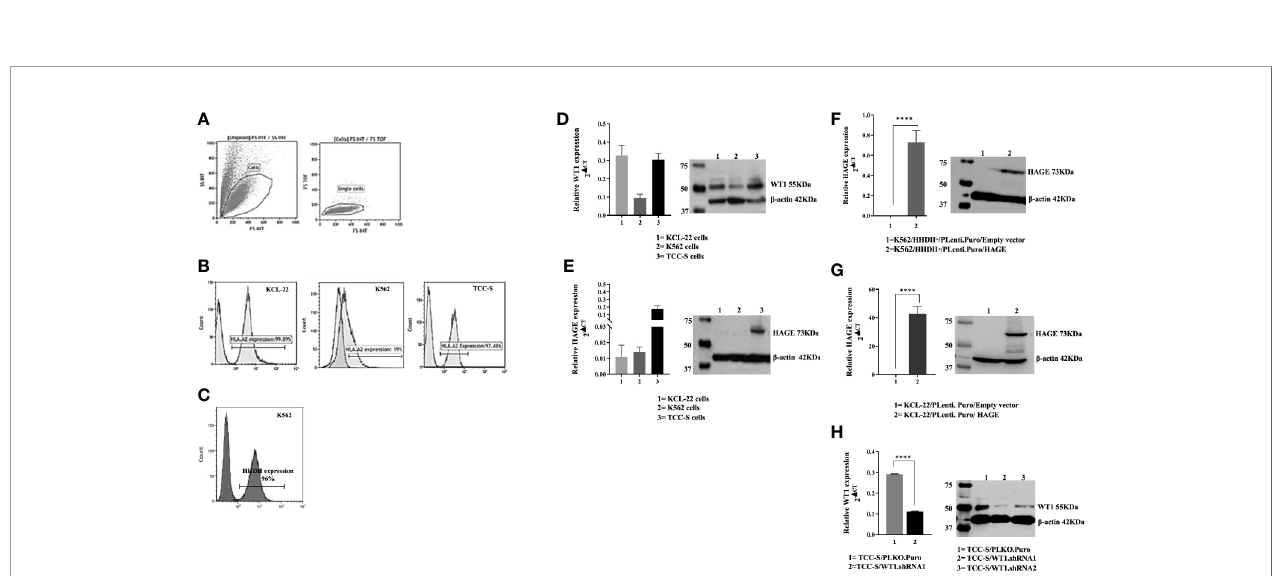
FIGURE 3 | HLA-A2, HAGE and WT1 expression in target cells: (A) Representative gating strategy used for the analysis of the surface expression of HLA-A2 on targets, as assessed by fl ow cytometry. Live cells were fi rst gated according to their Side Scatter and Forward Scatter pro fi le, and then single cells were selected, avoiding doublets. (B) The level of surface HLA-A2 expression was determined on basis of fl uorescence intensity depicted by a shift to the right of the histogram in comparison to unstained samples. (C) Overlay histogram illustrates HLA-A2 surface expression on the targets in comparison to a negative control (non-stained sample). The constitutive expression of WT1 and HAGE by KCL-22, K562 and TCC-S cell lines using RT-qPCR and Western blot shown in (D, E) . HAGE is transcribed at low levels in KCL-22 and K562 cells, but protein level are high. In contrast, TCC-S cells have constitutively high HAGE transcript and protein levels. WT1 was expressed by all cells studied as detectable by transcription and and protein levels. The Success of transfection; knock-in and knockdown, seen in (F – H) Values of PCR are expressed as the mean ± SD of two independent experiments. The doublet on WT1 seen in the Western blot might represent WT1 isoforms resulting from an alternative splicing event. ****p-value=<0.0001, highly signi fi